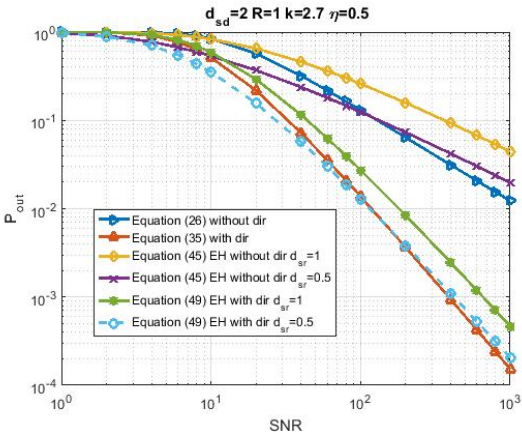
Figure 7. The optimal outage probability comparison under each different SNR.